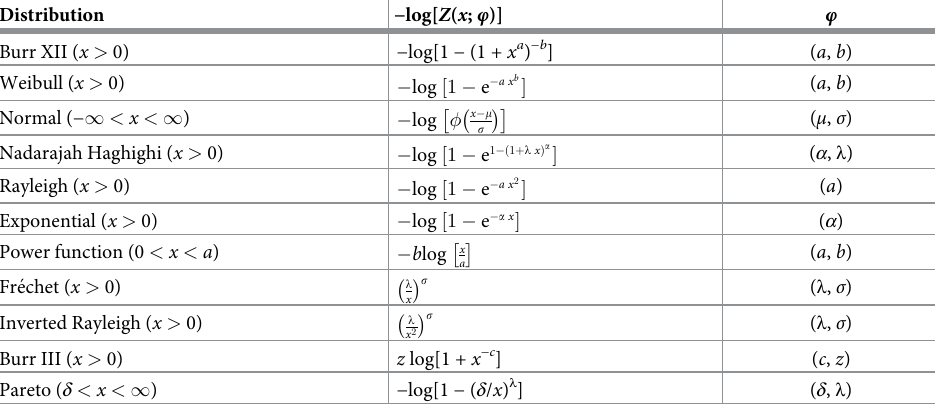
Table 1. Distributions and corresponding − log[ Z ( x ; φ )]